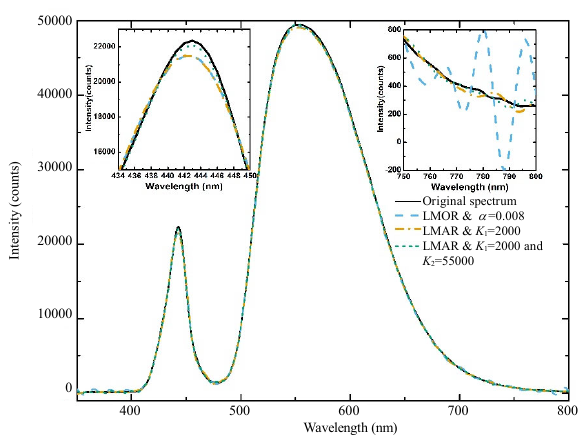
Fig. 9 Original spectrum and corrected spectra of white LED